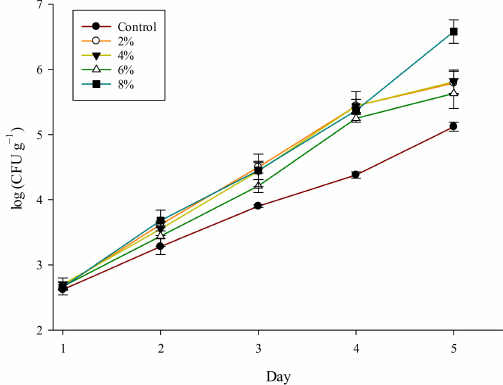
Figure 4. Microbiological challenge test results using Staphylococcus aureus